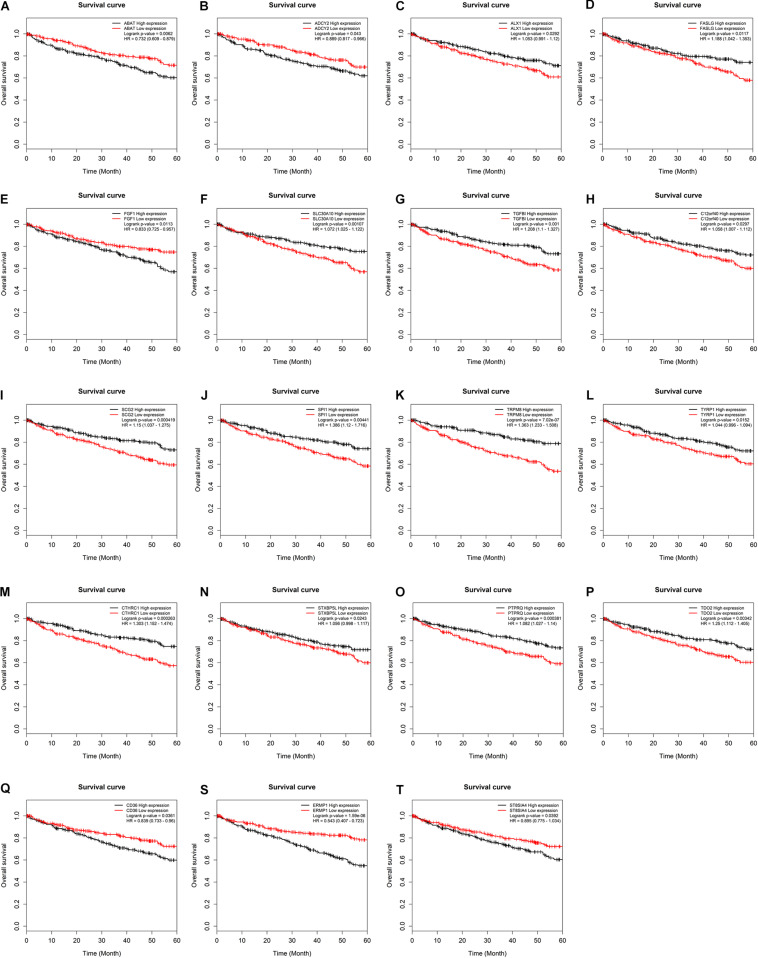
Kaplan–Meier survival curves for key mRNAs. (A) ABAT, (B) ADCY2, (C) ALX1, (D) FASLG, (E) FGF1, (F) SLC30A10, (G) TGFBI, (H) C12orf40, (I) SCG2, (J) SPI1, (K) TRPM8, (L) TYRP1, (M) CTHRC1, (N) STXBP5L, (O) PTPRQ, (P) TDO2, (Q) CD36, (S) ERMP1, (T) ST8SIA4. The horizontal axis presents the survival time while the vertical axis presents the survival rate. The green curve represents the low expression group while black curve shows high expression group.